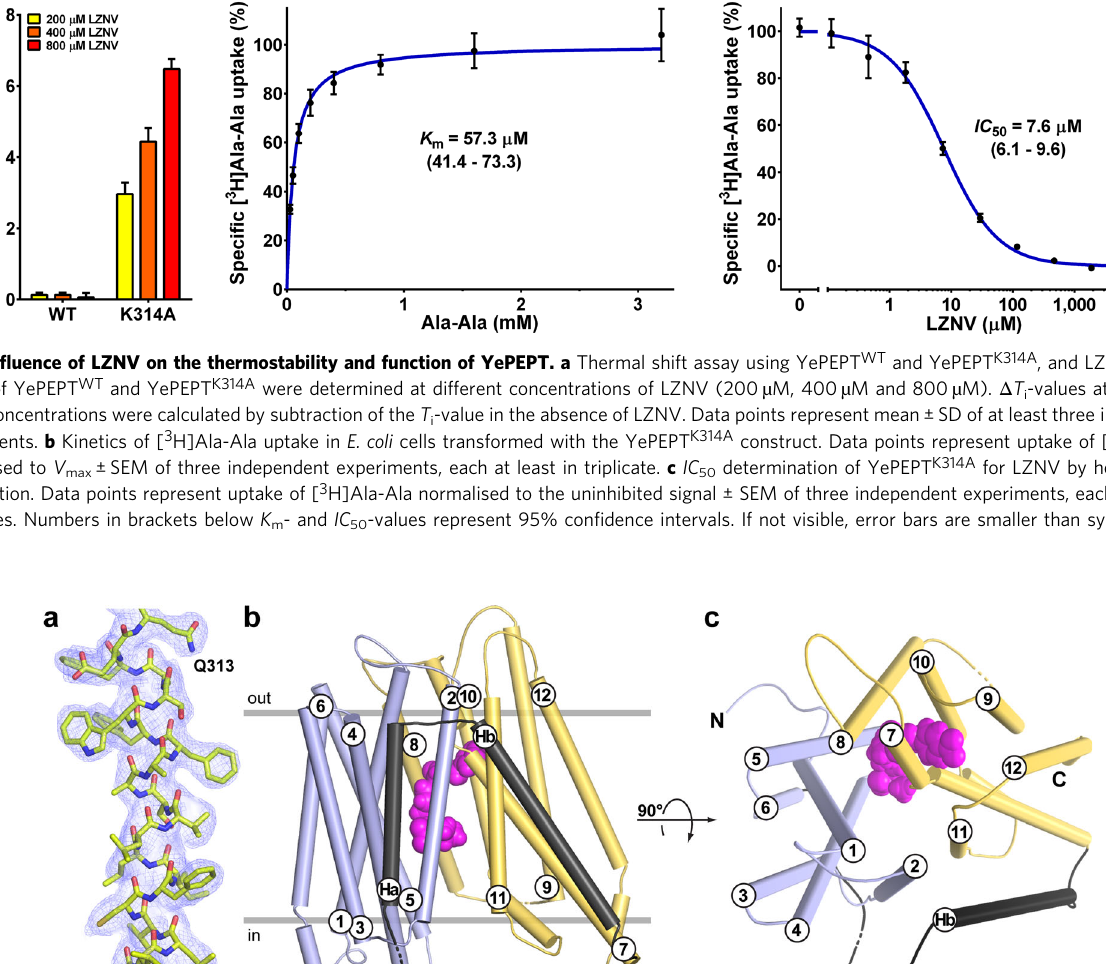
Fig. 2a. The structure contains 14 transmembrane helices (TMs) with an N- and a C-terminal six-helix bundle (Fig. 2b, c; bundles in blue and yellow) formed by TM1-6 and TM7-12, respectively. These bundles form the canonical major facilitator superfamily (MFS) fold 55,56 with a pseudo-twofold symmetry relation to each other. The two terminal bundles are connected by the two additional TMs Ha and Hb (Fig. 2b, c; depicted in black) in a hairpin-like structure, which is typical for prokaryotic peptide transporters 44,57 . The structure of YePEPT K314A is in an inward- facing conformation, with a central, conical cavity facing the cytosol. Extra density in the conical cavity (Supplementary Fig. 1) was attributed to one LZNV molecule (Fig. 2b, c; depicted in purple). The location of the LZNV molecule corresponds to the substrate-binding pocket according to previously published POT crystal structures in complex with ligands 30,36 – 43 .